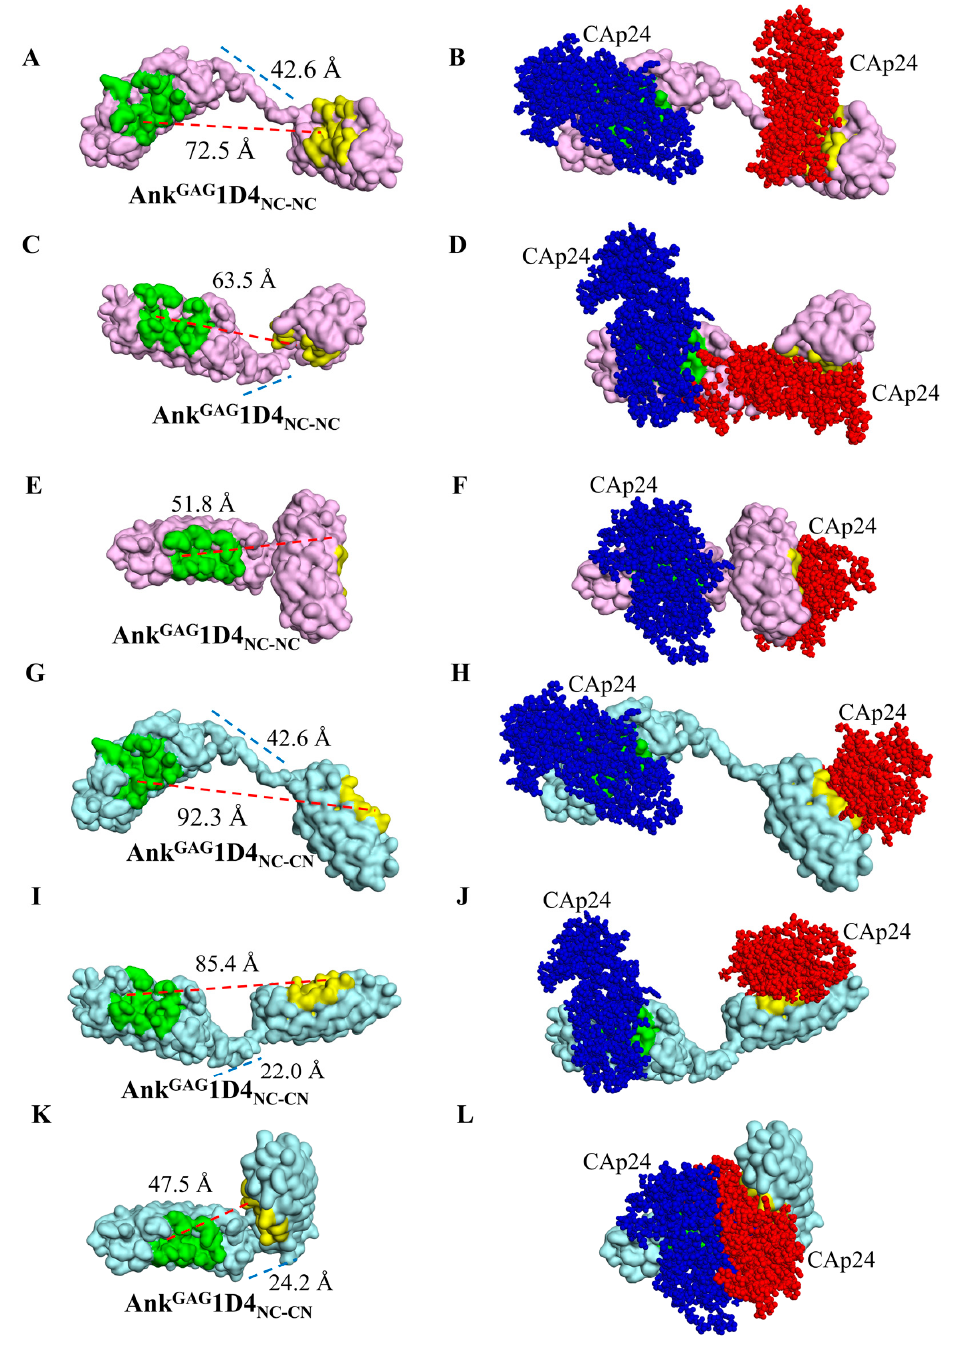
Figure 3. Characteristics of a conformational variant of Ank GAG 1D4 NC-NC and Ank GAG 1D4 NC-CN . Examples of ankyrin dimers were selected with a range of linker distance (blue dashed line) and binding sites distance (red line). The surface style of Ank GAG 1D4 NC-NC (pink) is shown in binding sites distances ranging from ( A ) long, ( C ) medium, and ( E ) short. Ank GAG 1D4 NC-CN (sky) structures are presented in panels ( G , I , K ) with the same pattern. Panels ( B , D , F ) are the superimpositions between the docked structure Ank GAG 1D4-CAp24 and the Ank GAG 1D4 NC-NC , compared with that of the Ank GAG 1D4 NC-CN in panels ( H , J , L ). The CAp24 binding to the first module is colored blue, and that of the second module is red. Panels ( D , L ) present a 1:1 interaction, whereas panels ( B , F , H , J ) are a 1:2 interaction.